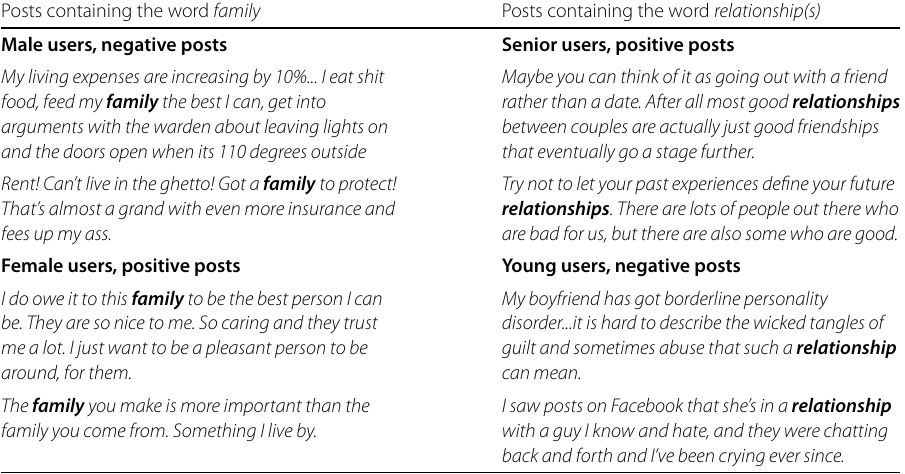
Table 6 Example posts of two discriminative words, which show the relevance of considering contextual information (users’ traits and occurrences’ polarity) for a proper interpretation Posts containing the word family Posts containing the word relationship(s) Male users, negative posts Senior users, positive